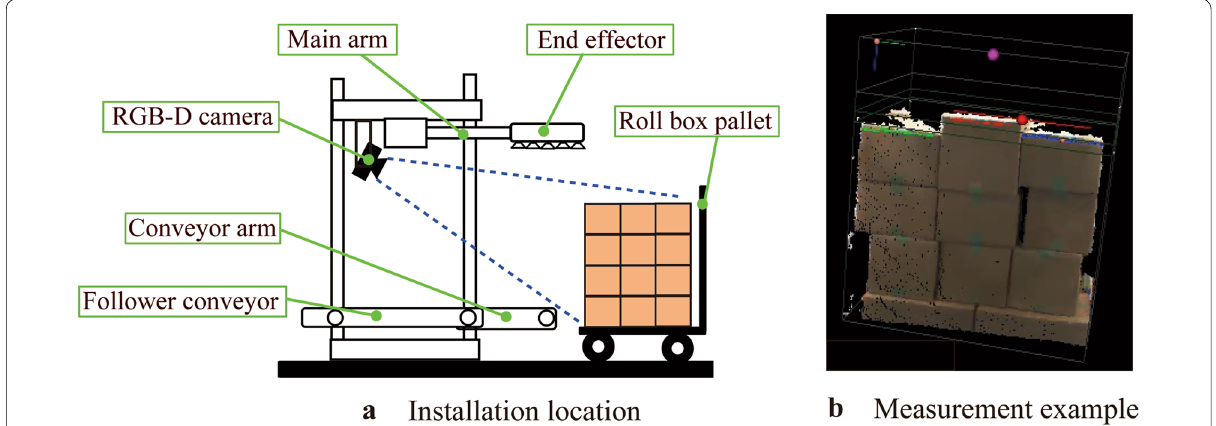
Fig. 30 Example of measurement results by RGB-D camera. a Installation location, b measurement